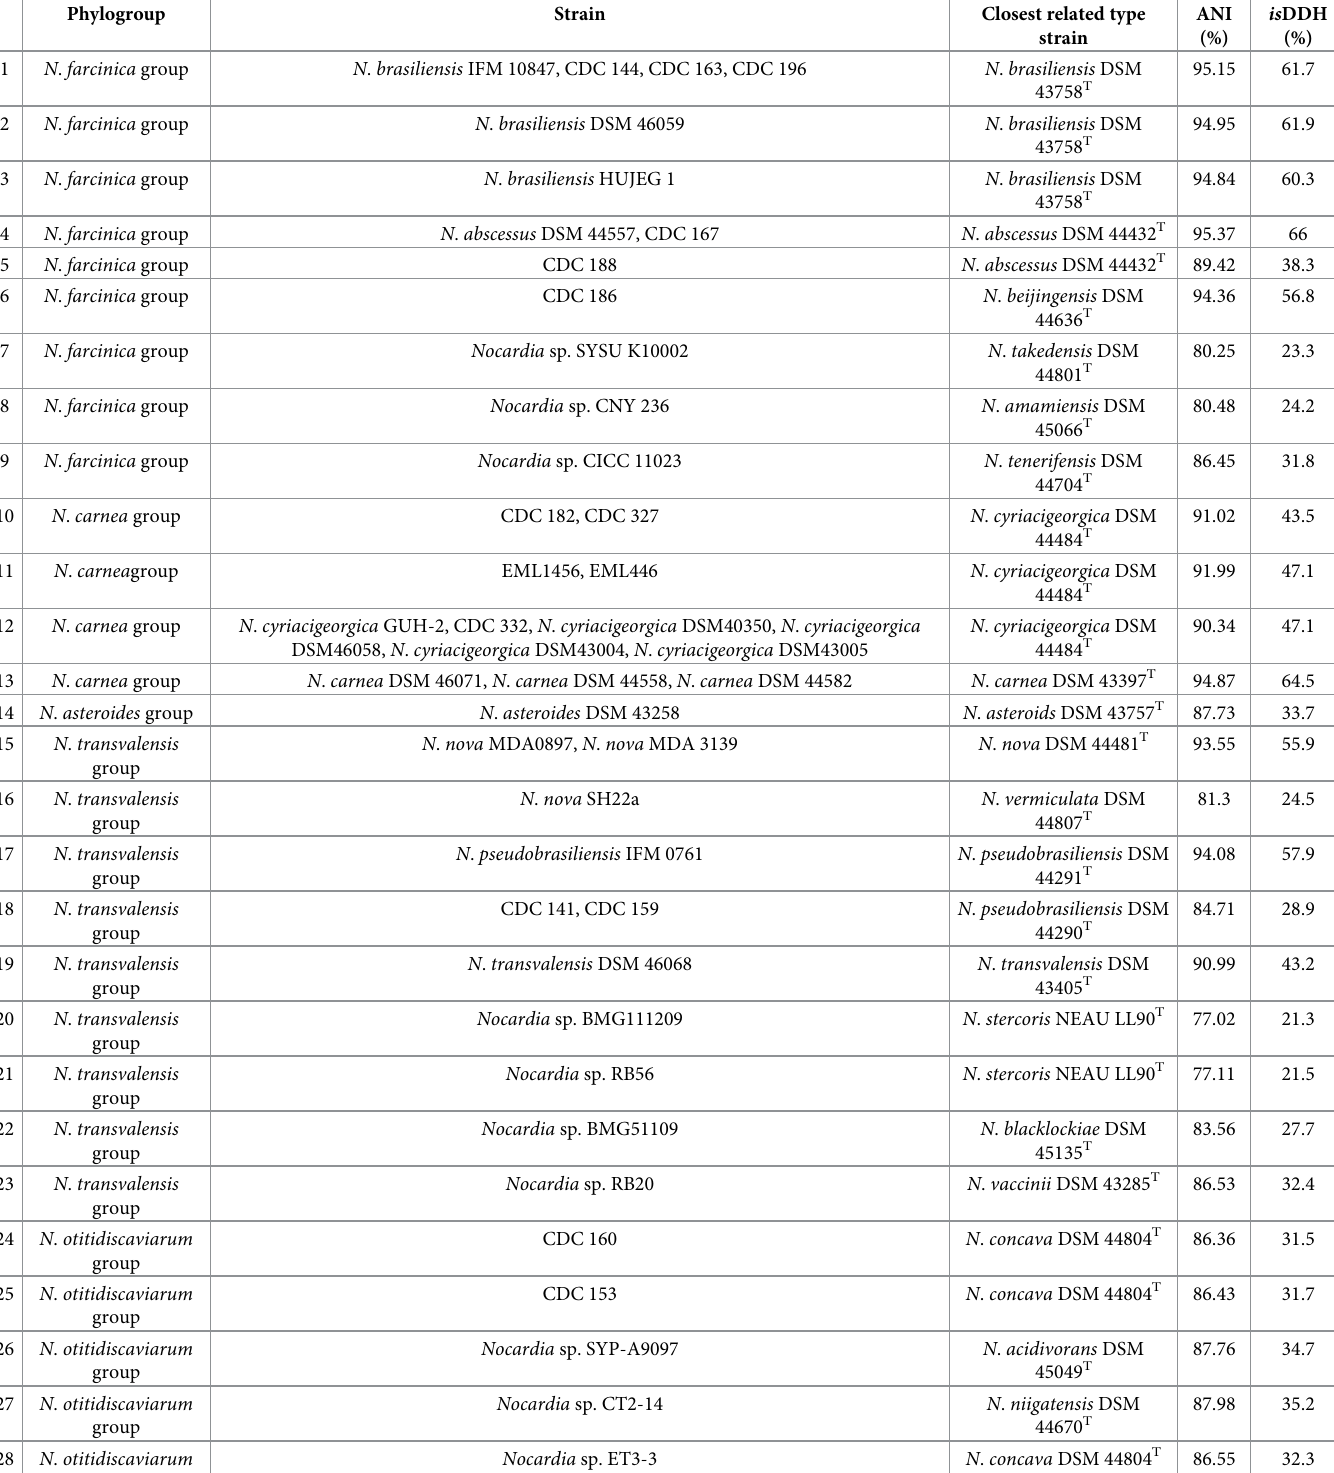
Table 2. General features of novel